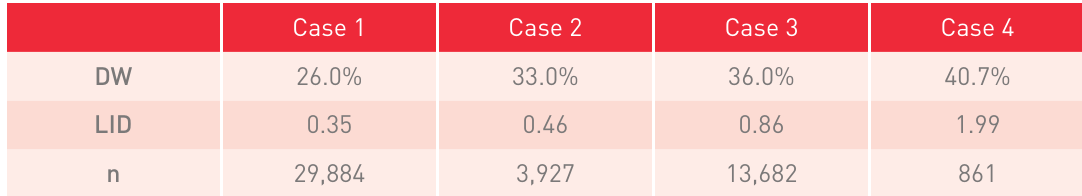
Table 6. DW levels from the four studies Case 1 Case 2 Case 3 Case 4 DW